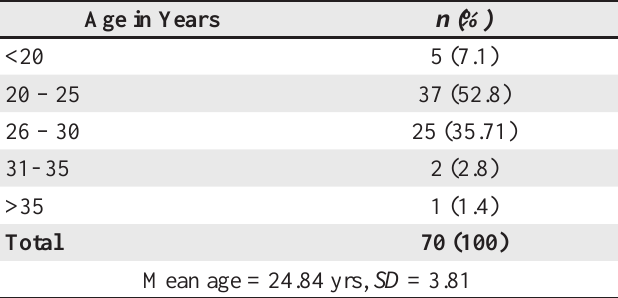
Table 1 . Age distribution of women with one previous LSCS